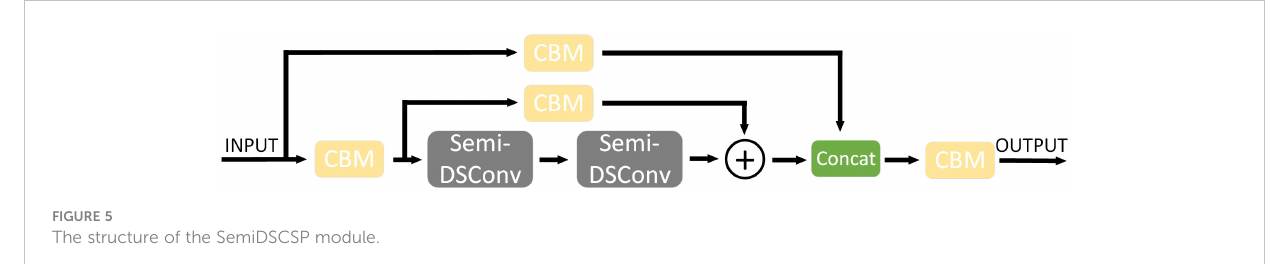
FIGURE 5 The structure of the SemiDSCSP